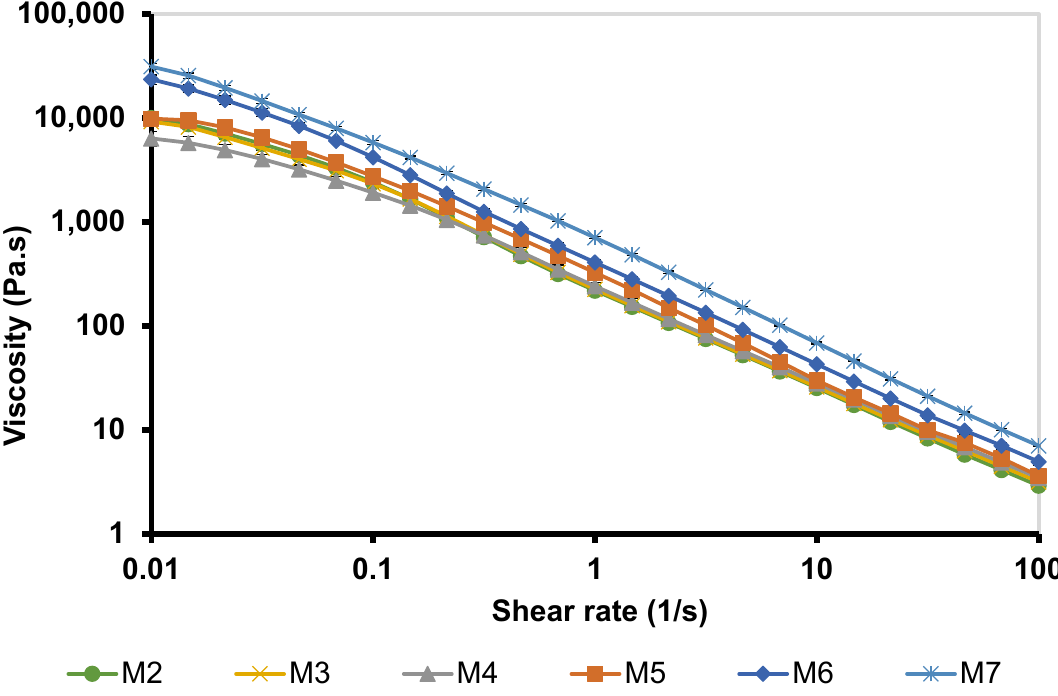
Figure 5. Viscosity curves of M 2-7 microgels at 35 °C and shear rates of 0.01–100 1/s.